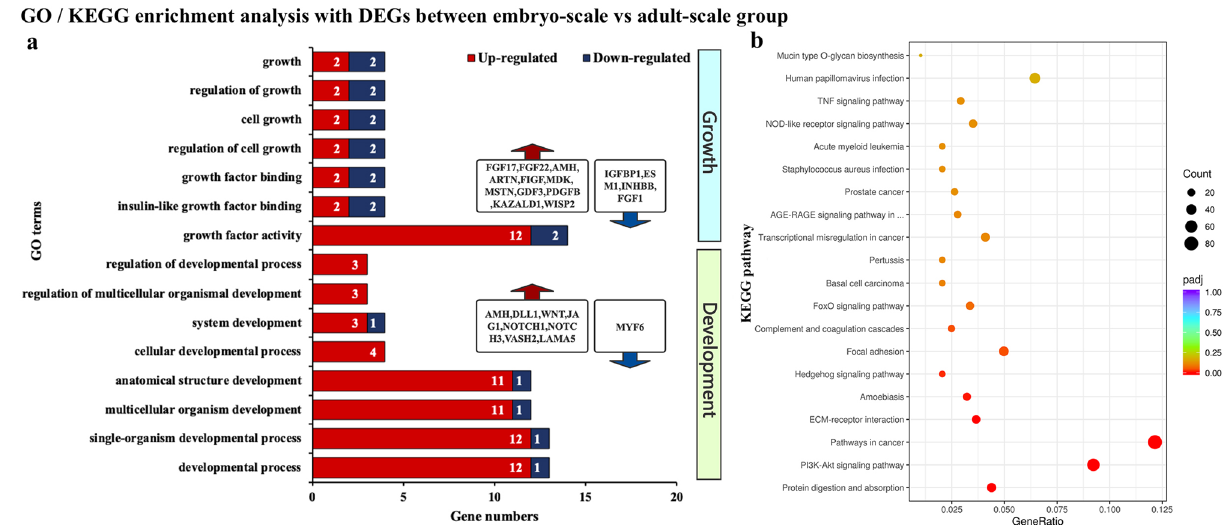
Figure 3. GO and KEGG enrichment analysis of DEGs between embryo-scale vs adult-scale group. ( a ) GO terms related to growth and development of skin appendages; ( b ) Bubble diagram of KEGG enrichment analysis.